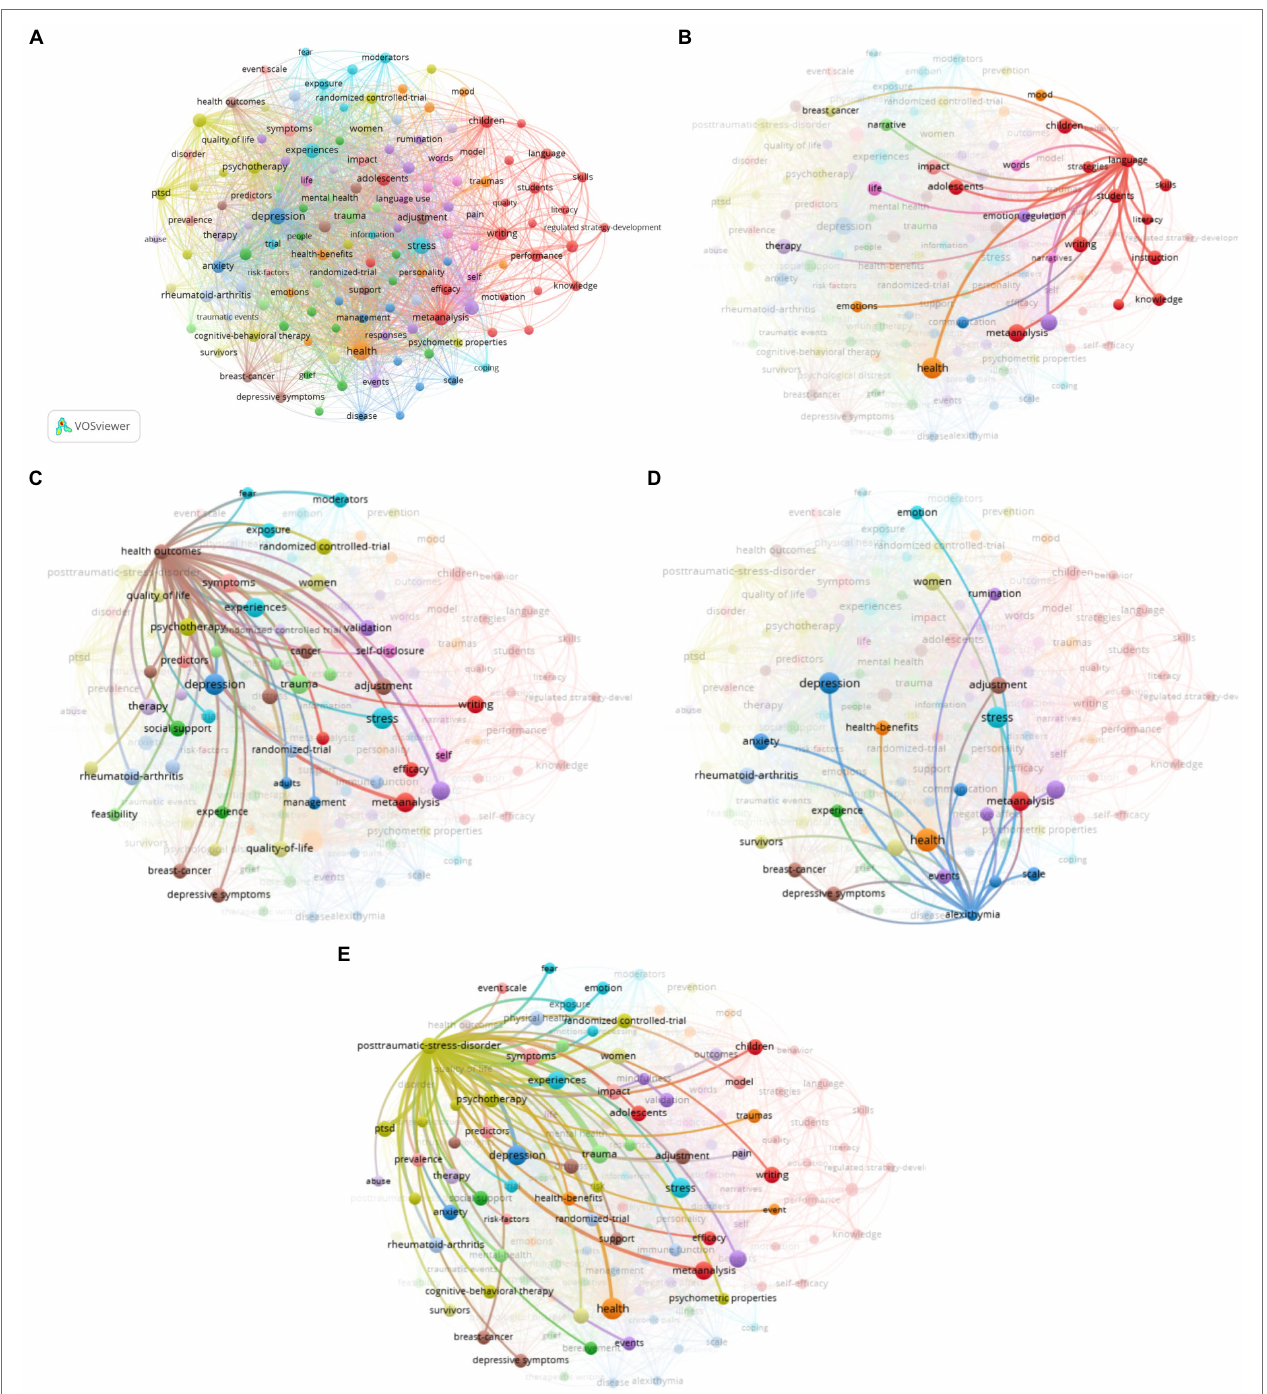
FIGURE 7 | (A) Results of co-word analysis. Excluding searching keywords/items: disclosure, expressive writing, emotional disclosure, intervention, written emotional expression, expression, written emotional disclosure, emotional expression, written disclosure, writing, interventions, expressive writing intervention, and writing intervention. Layout setting: attraction = 2, repulsion = − 3. (B) Relationship map between language and other keywords. (C) Relationship map between health outcomes and other keywords. (D) Relationship map between alexithymia and other keywords. (E) Relationship map between posttraumatic stress disorder (PTSD) and other